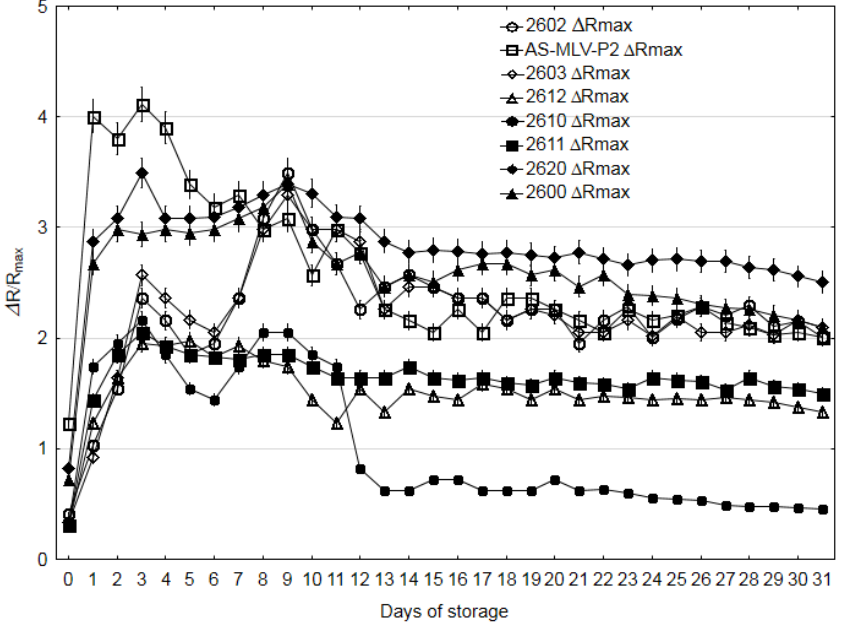
Figure 3. Maximum responses ( ∆ R / R max ) of rapeseed during 31 days of storage.